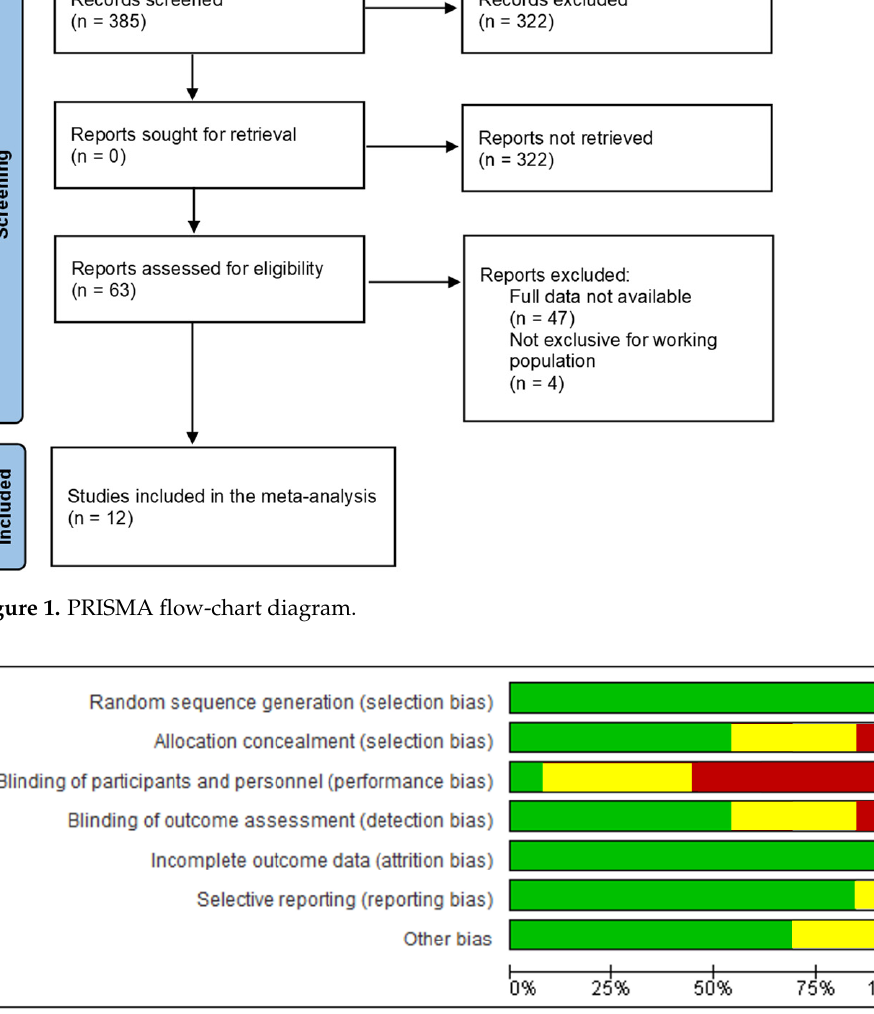
Figure 1. PRISMA flow-chart diagram.